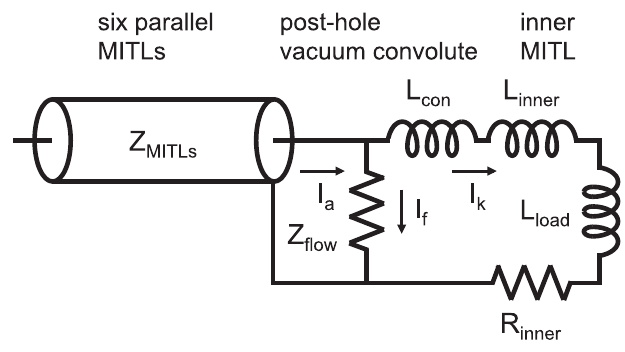
FIG. 14. Idealized circuit model of a coupled MITL-convolute- load system. This model is consistent with that given by Fig. 7, except here we represent the outer-MITL system as a trans- mission line instead of a lumped